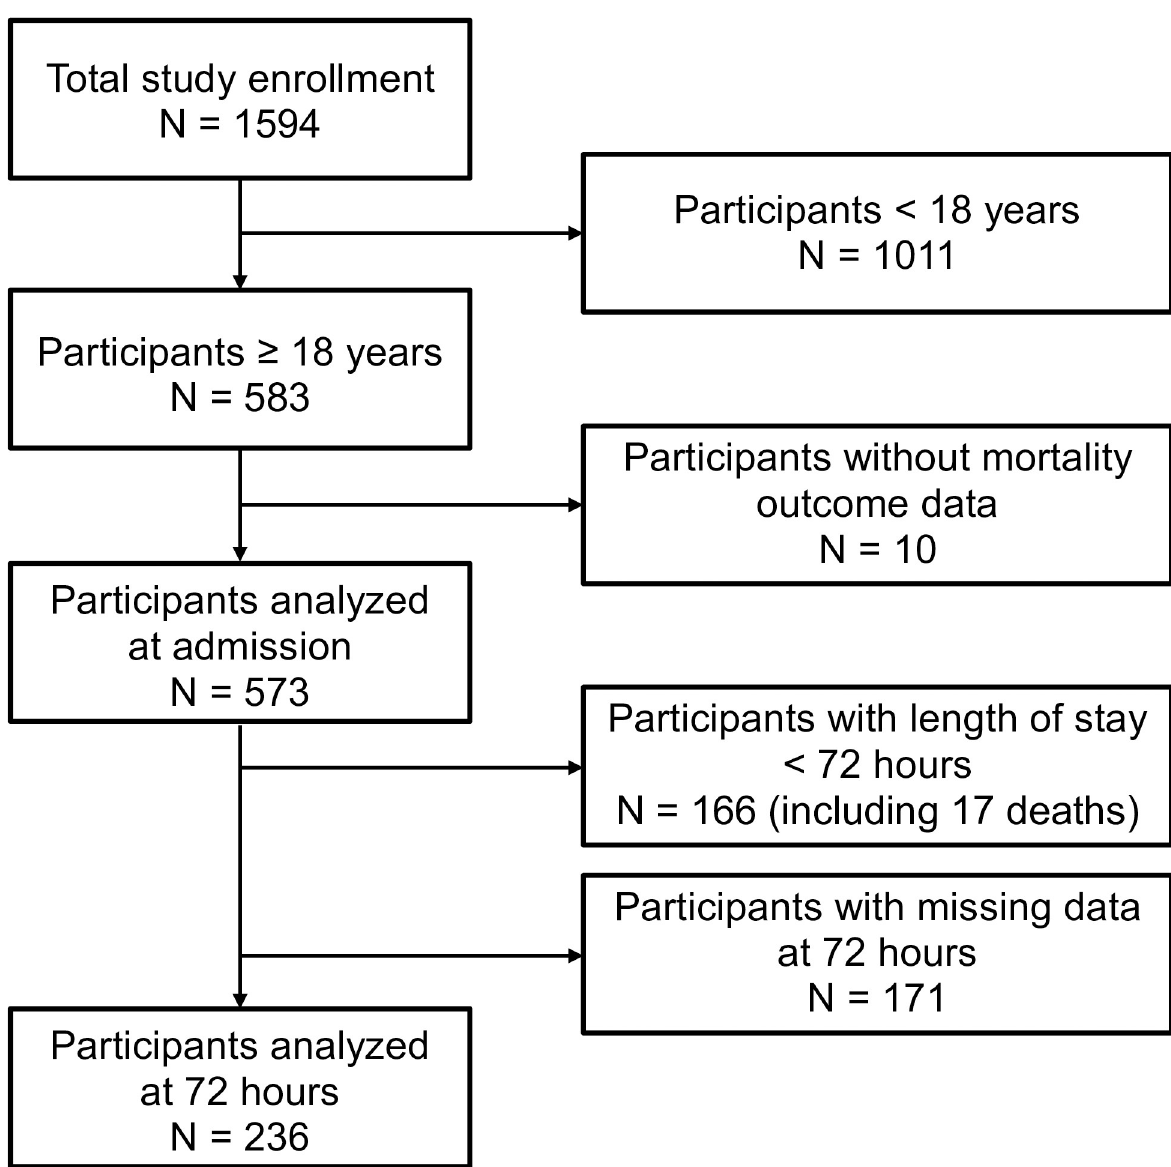
Fig 1. Flow diagram of participant inclusion in the external validation study of the UVA score in a cohort of patients admitted to hospital with acute infection in Gitwe, Rwanda. sensitivity analyses whereby we imputed a two for oxygen saturation and determined the upper and lower UVA score AUC bounds (95% CI) as 0.77 (0.69–0.86) and 0.77 (0.69–0.86), respectively. Similarly, we also imputed a two for HIV and established the upper and lower UVA score AUC bounds (95% CI) as 0.77 (0.69–0.86) and 0.75 (0.65–0.85), respectively. Increasing UVA scores were associated with increased case fatality rates and odds ratio of death (Figs 3 and 4; Table 3). The positive predictive values (95% CI) of the scores at com- monly used cut-offs were: UVA > 4, 0.35 (0.15–0.59); modified UVA > 4, 0.35 (0.15–0.59); qSOFA > 1, 0.14 (0.07–0.24); amalgamated qSOFA > 1, 0.44 (0.20–0.70); and MEWS > 5, 0.14 (0.08–0.22) (Table 4). When calculated using data obtained from patients at 72 hours